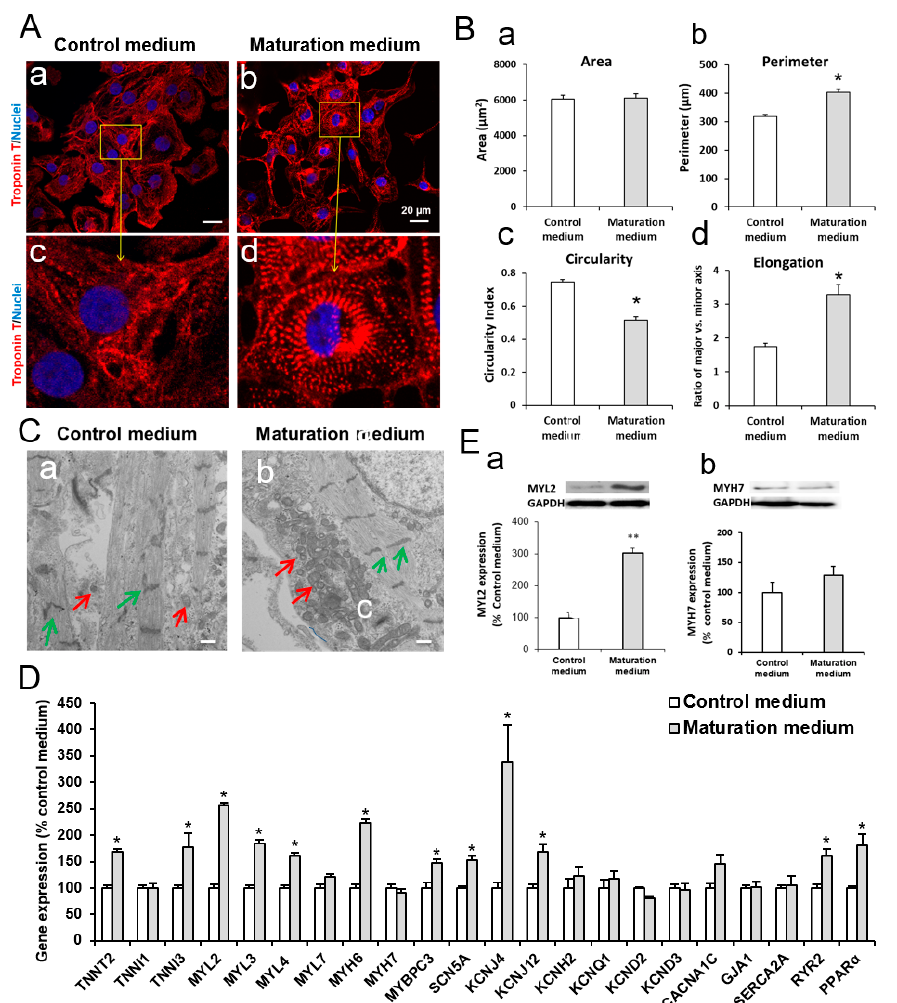
Figure 3. The effect of fatty acid-contained cardiomyocyte maturation medium (no glucose) on the maturation of 1013 iPSC-derived CMs. ( A ) Representative immunofluorescent images of iPSC-CMs (day 34) cultured with control culture medium (a) and maturation medium for 7 days (b). Figures A-c and A-d are the magnified images marked by yellow rectangles in Figures A-a and A-b, respectively. Scale bar = 20 µm. ( B ) Analysis of cell area (a), perimeter (b), circularity (c), and elongation (d) of iPSC-CMs using ImageJ software. n = 50–64 * p < 0.05 vs. control medium . ( C ) Representative electron microscopy images of iPSC-CMs (day 38) treated with control medium (a) and maturation medium (b) for 7 days. Scale bar = 500 nm. Maturation medium-treated iPSC-CMs showed well-aligned visible Z-lines and increased mitochondria within the cells compared with the cells cultured in control medium. Z-lines and mitochondrial are indicated by green and red arrows, respectively. ( D ) Real time PCR analysis of the effect of maturation medium on the cardiomyocyte maturation-related gene expression. n = 4 * p < 0.05 vs. control medium . (iPSC-CMs day 38) ( E ) Western blot analysis of the effect of maturation medium on MYL2 (a) and MYH7 (b) protein expression in iPSC-CMs (day 38). n = 4, ** p < 0.01, vs. control medium . Note: TNNI: troponin I; TNNT: troponin T; MYL: myosin light chain; MYH: myosin heavy chain; MYBPC: myosin binding protein C; SCN5A: sodium voltage-gated alpha subunit 5; KCNJ: potassium inwardly rectifying channel subunit J; KCNH: potassium voltage-gated channel subfamily H; KCNQ: potassium voltage-gated channel subfamily Q; KCND: potassium voltage-gated channel, subfamily D; CACNA1C: calcium voltage-gated channel subunit alpha1 C; GJA1: gap junction protein, alpha 1; SERCA2A: sarcoplasmic/endoplasmic reticulum Ca 2+ ATPase 2a; RYR2: cardiac ryanodine receptor; PPAR α : peroxisome proliferator-activator receptor alpha.